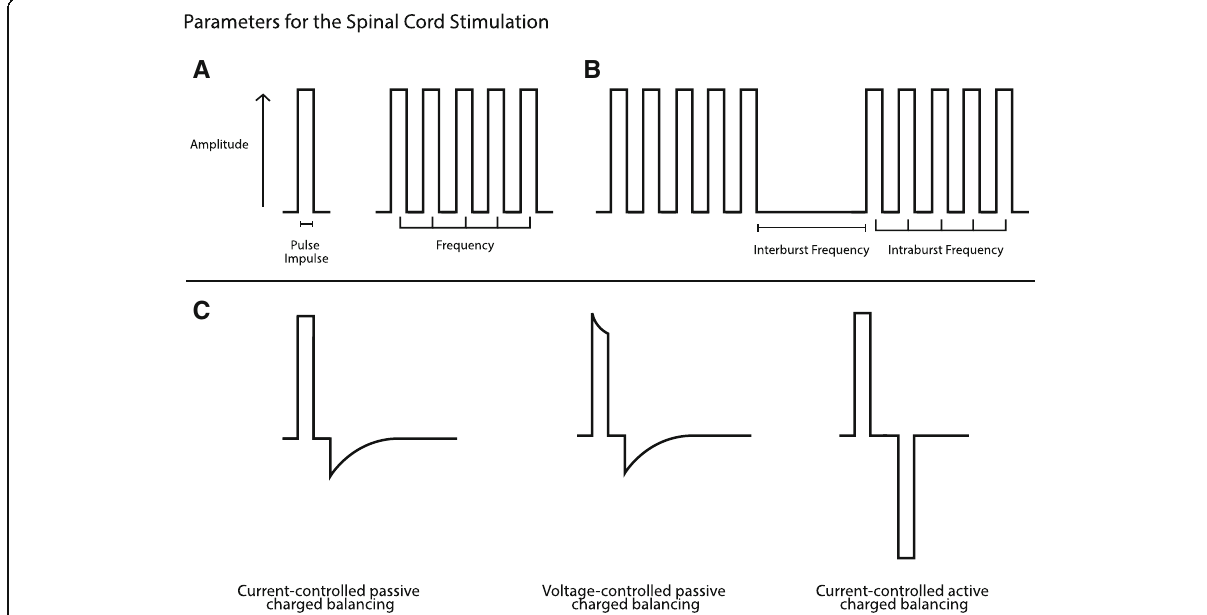
Fig. 2 Parameters for Spinal Cord stimulation: Panel a : Amplitude: the peak current delivered, measured in milliamperes (mA). This impacts the number of fibers recruited and intensity of paresthesia. Amplitudes that are subthreshold do not generate an action potential and thus do not create paresthesia. Pulse Width (PW): the time over which the current is delivered, measured in microseconds ( μ s). The PW determines the amount of charge delivered for a given amplitude. Mathematical integration of the charge waveform yields the total charge delivered per pulse, measured in nanocoulombs. Increases in PW may recruit additional A β Fibers and broaden the area of paresthesia. Frequency: the number of pulses per second, measured in hertz (Hz). Panel b : Burst SCS parameters describing inter-burst frequency, or the number of bursts per second, and intraburst frequency, describing the number of pulses within a burst, measured in Hz. Panel c : The waveform or shape of the pulse can be divided into two segments: depolarization, or deflection above electroneutrality, and repolarization, the return to baseline. The depolarization waveform is determined by whether the system delivers the pulse in a Current-Controlled (CC) or Voltage-Controlled (VC) fashion. Current describes the flow of charge whereas voltage describes the potential difference between